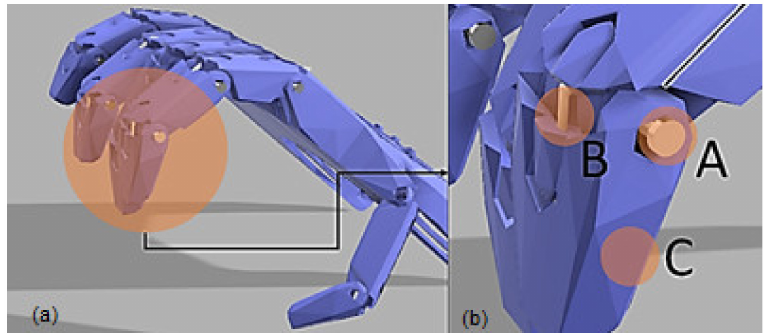
Figure 10. Configuration of materials and components: ( a ) full hand view; ( b ) finger detail, where: Point A—nickel plated steel mounting bolt, Point B—high strength line, Point C—PETG (Polyethylene Glycol Terephthalate) prosthesis